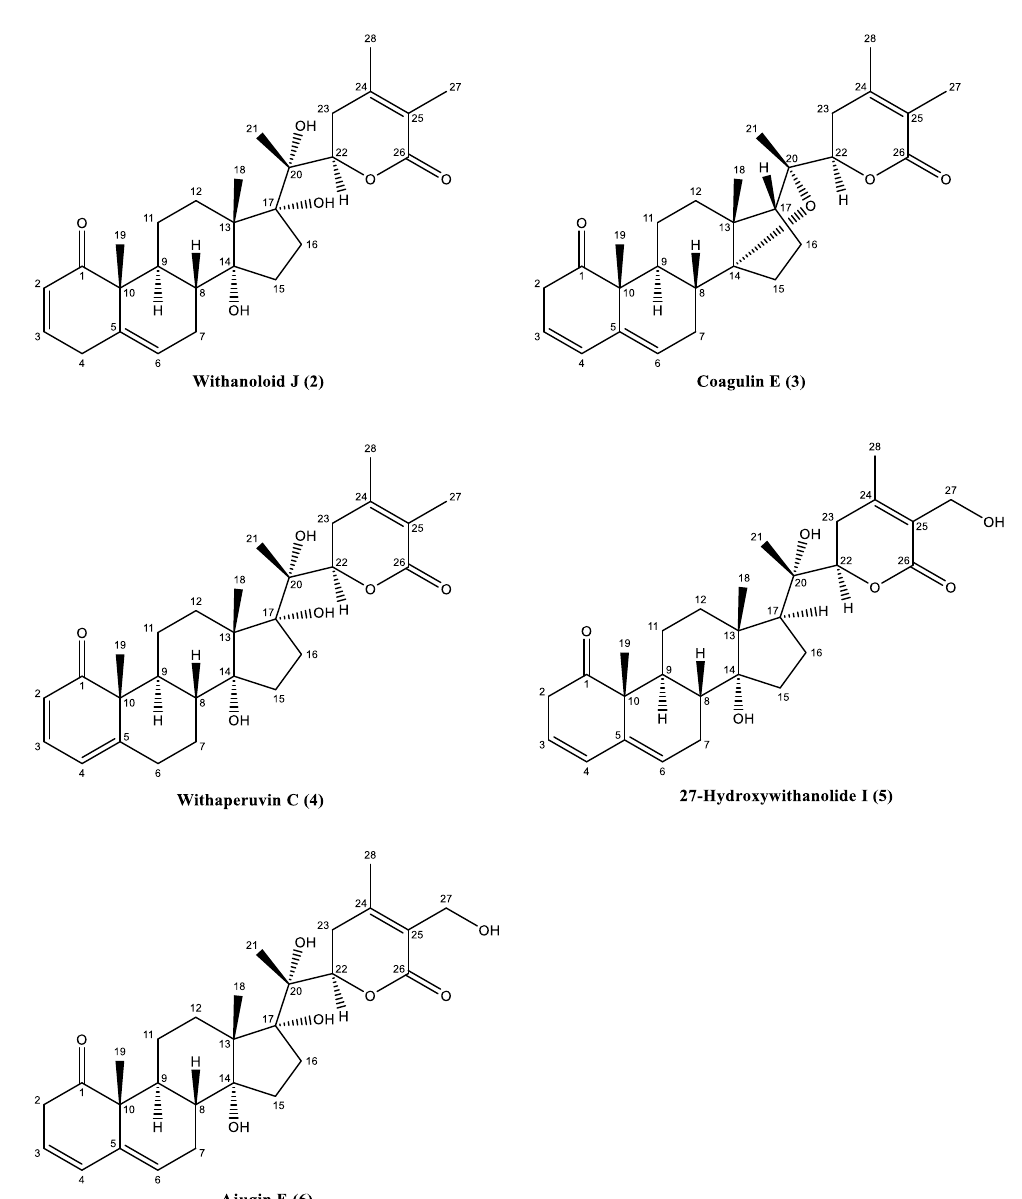
Figure 2. Structures of compounds 2 to 6 isolated from w. coagulans .